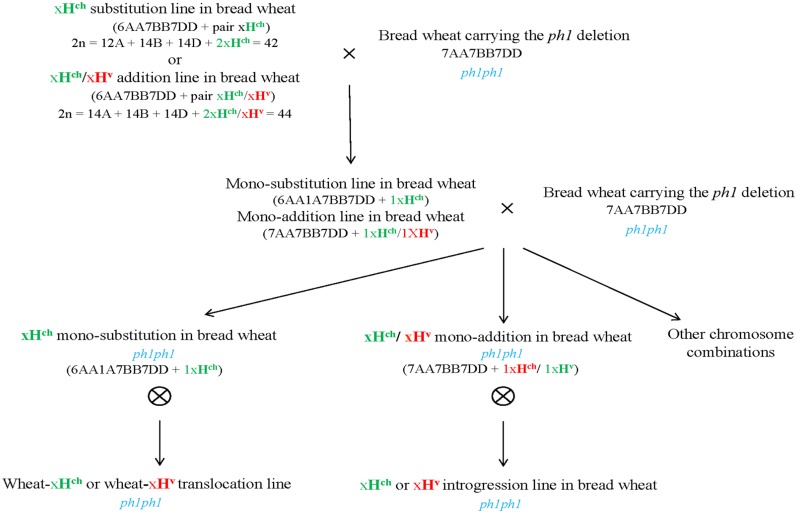
Development of Hordeum sp. introgression lines in hexaploid wheat in the ph1b mutant background. Crosses between a Hordeum sp. substitution or addition line in bread wheat cv. Chinese Spring (2n = 6x = 42) and the ph1b mutant in hexaploid wheat were developed and backcrossed to the ph1b mutant to obtain Hordeum sp. introgressions in the absence of the Ph1 locus. Screening and characterization of chromosome complements were carried out by multicolor in situ hybridization and molecular markers analyses.